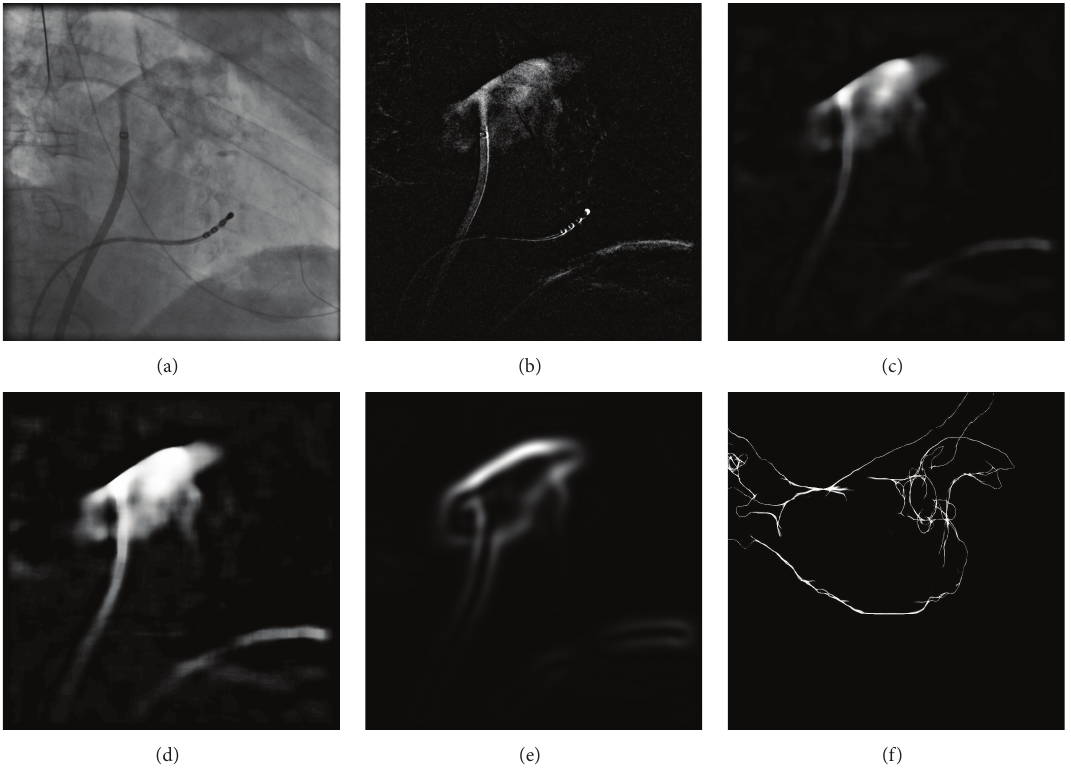
Figure 3: Using the original image (a), a DSA image (b) is computed. After median filtering (c), the remaining motion artifacts from the catheter have vanished. Only the boundary at the diaphragm remained. Afterwards, all pixels are weighted by a sigmoid function (d) to get a more homogeneous value distribution inside the contrasted area. Edges are extracted using derivatives of Gaussian with a large kernel size (e). Finally, the similarity to the rendered edges (f) is